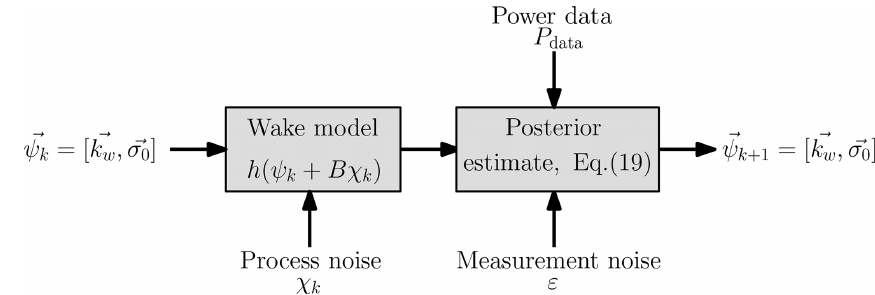
Figure 2. Schematic of the ensemble Kalman filter parameter estimation methodology. The wake model predicts the power production given the wake model parameters ψ k from time step k and the modeled process noise χ . The power data from the LES are augmented with modeled measurement noise ε . The wake model predictions, h ( ψ k + Bχ k ), process and measurement noise, and power data are leveraged to compute the parameters in the k + 1 time step ψ k + 1 using the measurement analysis step (Eq.